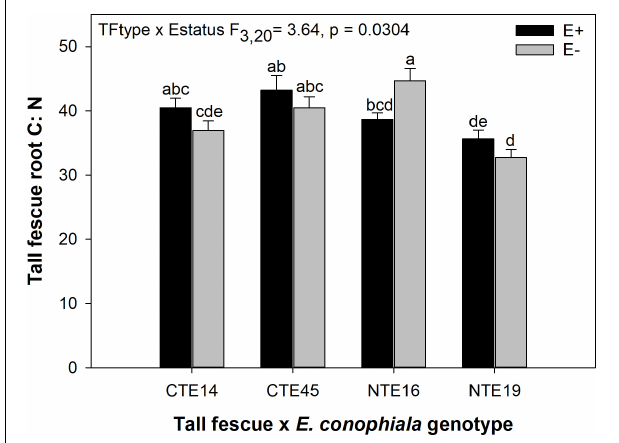
FIGURE 3 | Interactive effects of tall fescue symbiotic genotype and endophyte status on the ratio of C:N in belowground tall fescue root tissue. Bars indicate means ± 1 S.E. Bars sharing no common letter (a,b,c,d,e) indicate significant differences between means ( α =